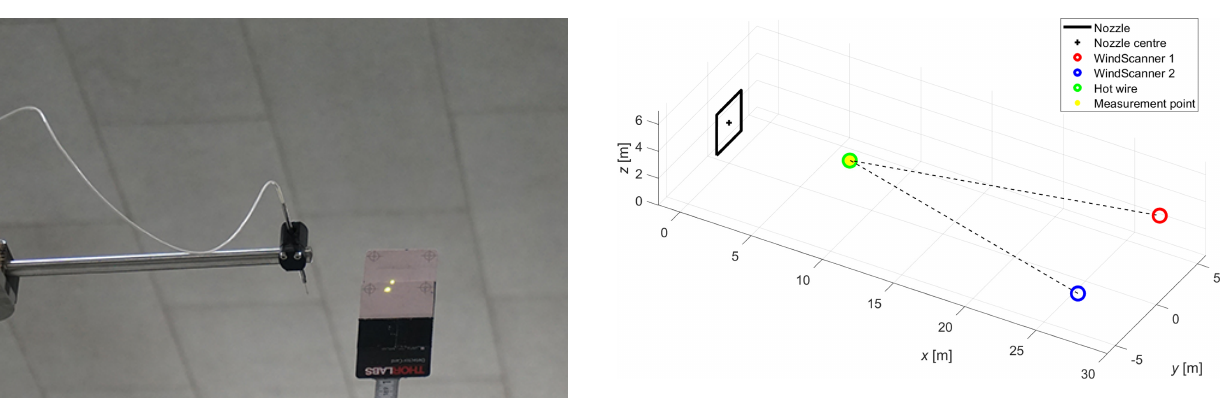
Figure 5. Schematic measurement setup of the two WindScanner lidars and the hot wire in the wind